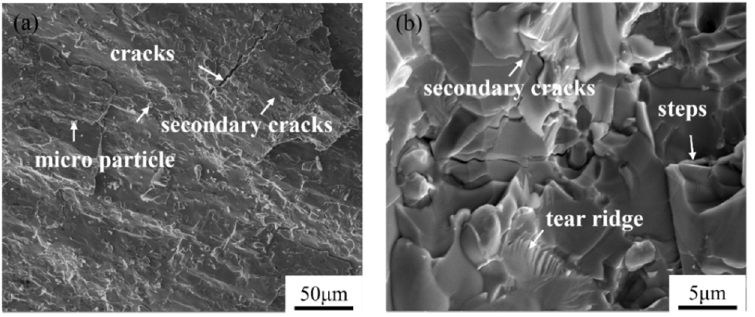
Figure 9. Images of fracture morphology of LMD-formed CoCrMoNbTi 0.4 high entropy alloy with static compression at E l = 3.6 J/mm. ( a ) Low magnification; ( b ) high magnification.